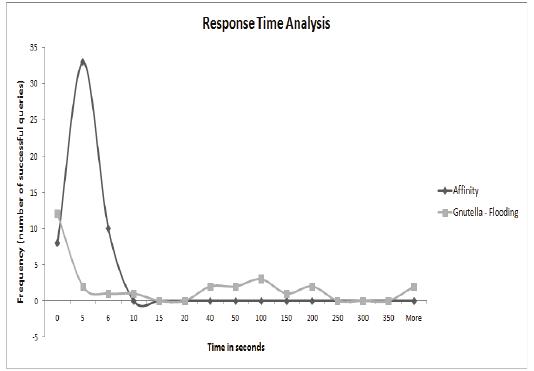
Fig. 6. Frequency distribution of response time analysis - Gnutella vs. Affinity